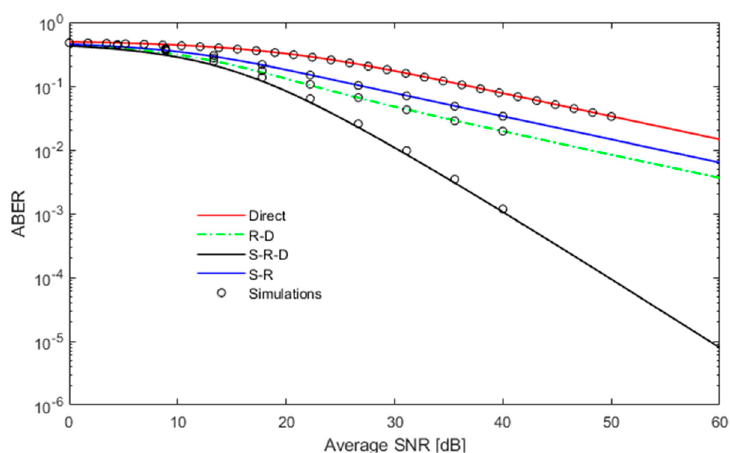
Figure 8. ABER vs. SNR of FSO over L-N channel for moderate turbulence with distance 400–600 m, the number of relays = 3, and w z = 0.5 m.